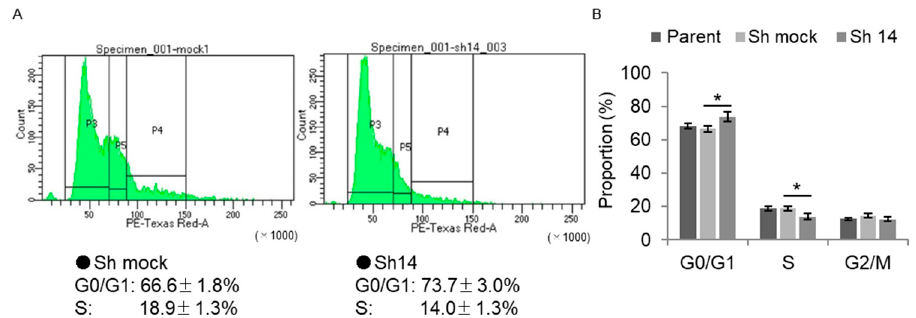
Figure 7. Cell-cycle analysis via flow cytometry in BMAL1 -knockdown immortalized human prostate cells. ( A ) Representative graphics of control cells and BMAL1 -knockdown cells. The cell cycle was determined with propidium iodide (PI) staining. ( B ) Calculated proportion of cells in G0/G1, S and G2/M phases ( N = 6). * p < 0.01 using one-way ANOVA with Tukey’s post hoc test.